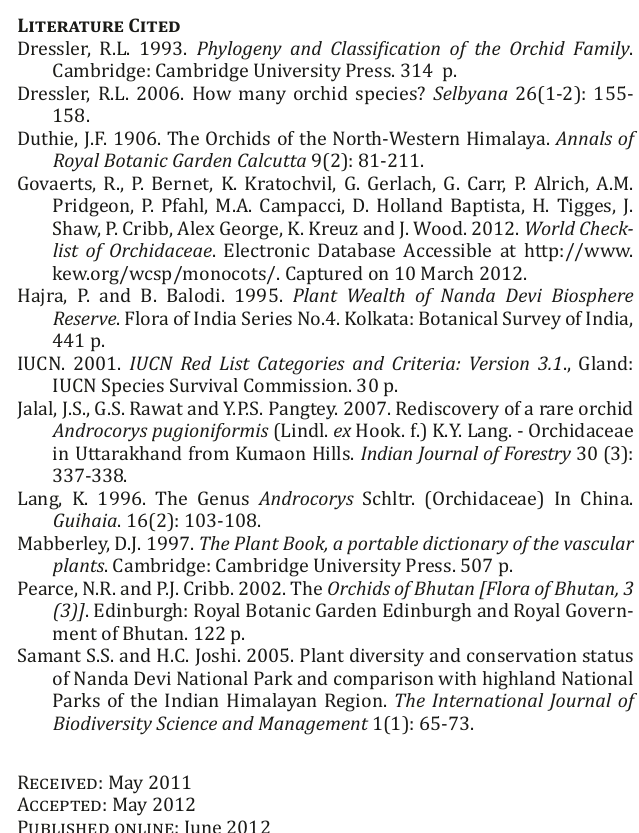
(Lindl. ex Hook. f.) K.Y.